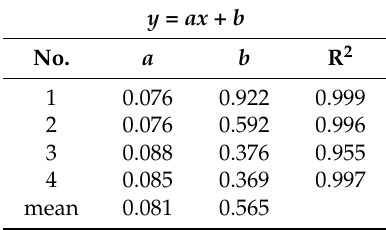
Table 10. Properties of the anodizing regression lines from Figure